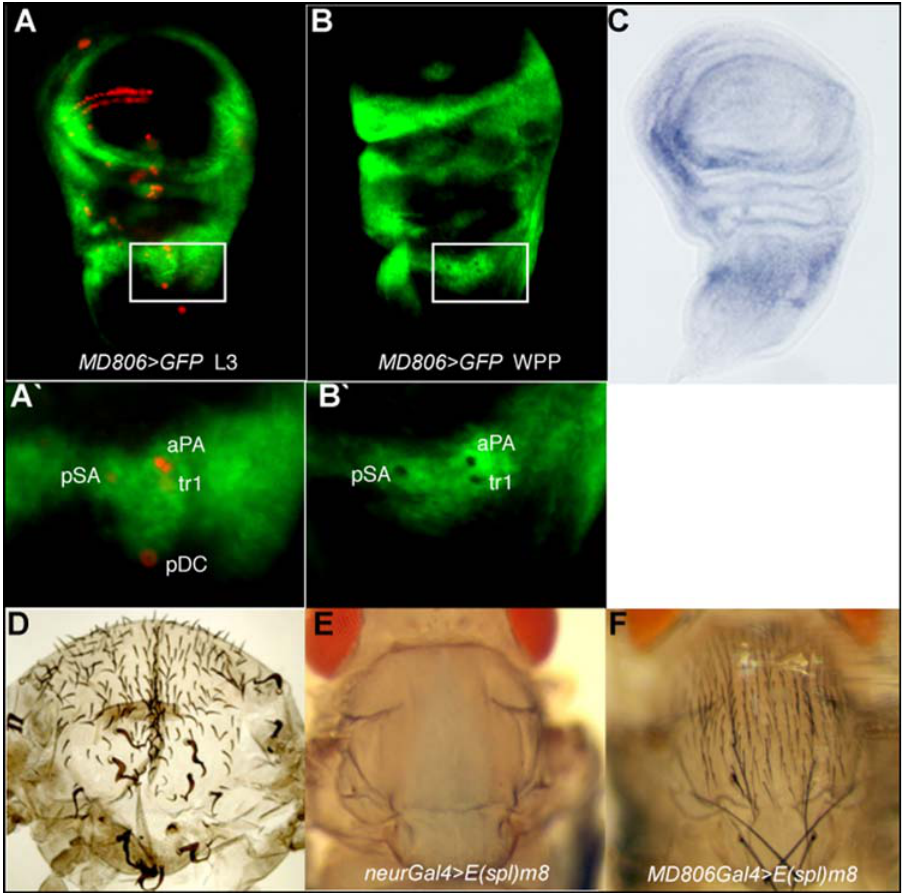
Figure 3. Toll-8 is expressed at varying levels in the disc epithelium and expression is extinguished in the neural precursors. (A–B’), GFP expression driven by the Toll-8[MD806]Gal4 driver in discs from third instar larvae (A, A’) and white prepupae (B, B’) respectively. Expression is strong over the lateral notum but is excluded from the sensory organ precursors, which are stained for neuralized activity (A101, anti- b galactosidase; red). At the third larval instar, expression is clearly missing from the aPA precursor, and by prepupal stages, additional ‘‘holes’’ corresponding to the posterior supraalar (pSA) and sensilla trichoidea 1 (tr1) precursors are obvious in the lateral notum. (A’) and (B’) are higher magnifications of boxed areas in (A) and (B). (C), the expression of Toll-8 as revealed by in situ hybridisation with a Toll-8 RNA probe. Expression is strong in the lateral notum. (D), thorax of a fly of the genotype y f 36a abx . f + . Gal4; UAS Flp; Toll-8-Gal4. All MD806 -positive cells in these flies simultaneously express flipase which induces high levels of FRT-mediated recombination. Consequently, all bristles marked with f 36a arise from cells expressing Toll-8 . As can be seen in (3D), f 36a bristles can be seen even in the medial region of the notum. (E), thorax of a neurGal4 . UAS-E(spl)m8 fly showing a complete loss of bristles. (F), thorax of Toll- 8Gal4 . UAS-E(spl)m8 fly showing a full complement of bristles, indicating that Toll-8 is not expressed in the